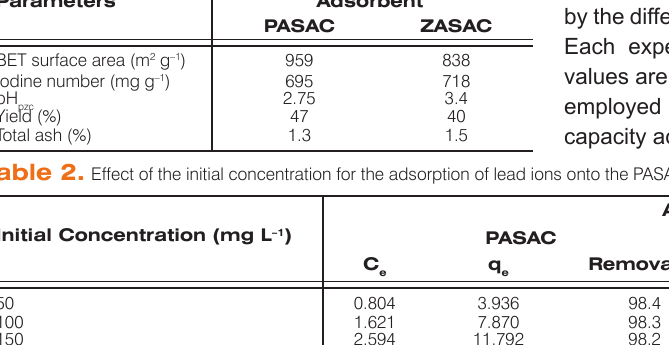
Table 1. Characteristic of the PASAC and ZASAC. Parameters